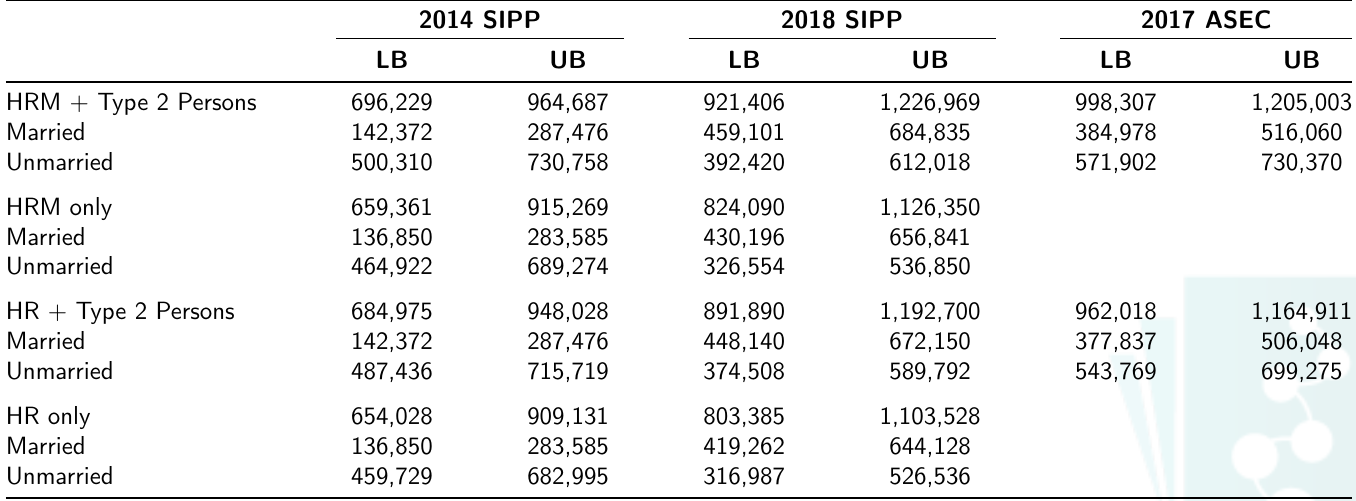
Table A.2: Estimated lower and upper bounds at 95% confidence level for counts in Table